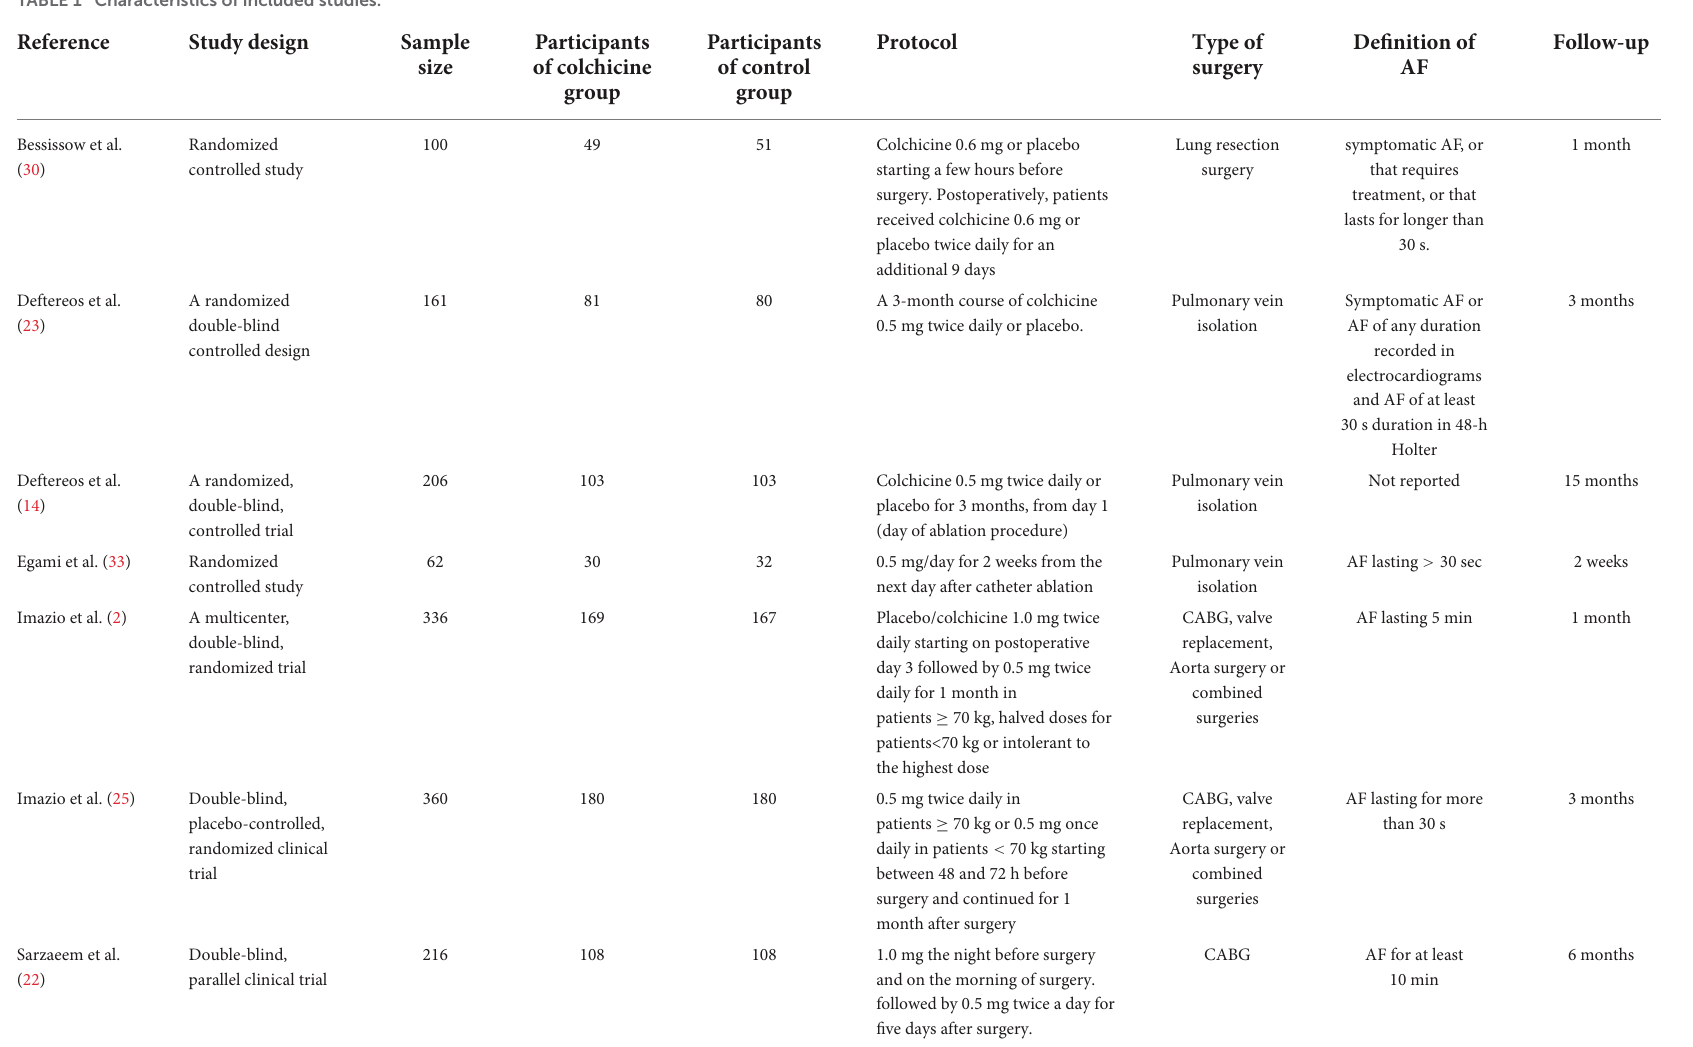
TABLE 1 Characteristics of included